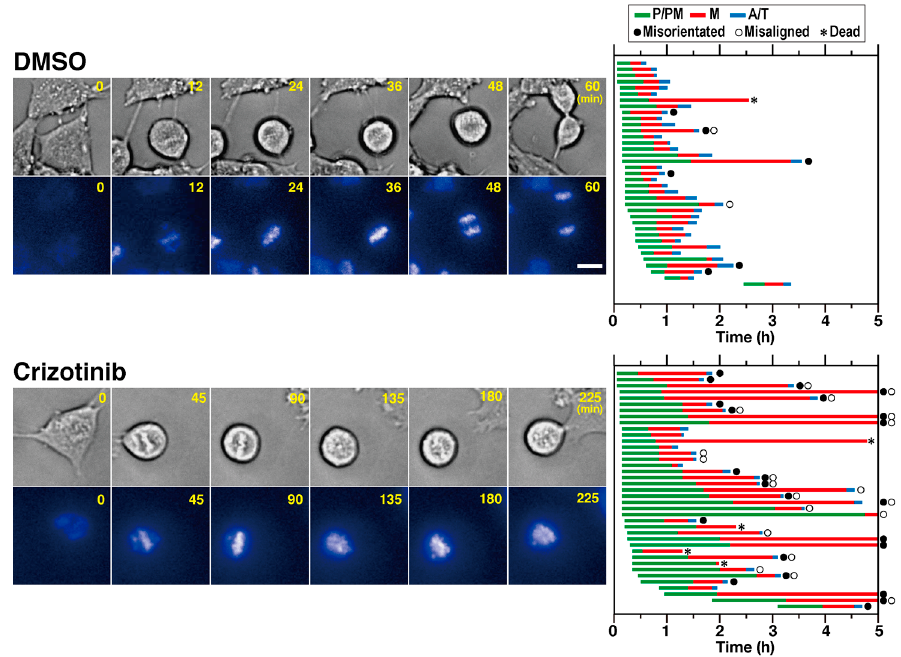
Figure 2. Crizotinib delays both prophase / prometaphase and metaphase. The SH-SY5Y cells were synchronized with 4 µ M RO-3306 and their M-phase progression in presence and absence of 1 µ M crizotinib were observed every 3 min for 5 h using time-lapse imaging. Representative images of solvent control (DMSO) and crizotinib-treated cells are shown. Scale bar = 10 µ m. Durations of prophase and prometaphase (P / PM, green), metaphase (M, red), and anaphase and telophase (A / T, blue) for 37 control and 39 crizotinib-treated cells are shown in the graph. Cells showing misoriented spindle, misaligned chromosomes, and cell death are indicated by closed circle, open circle, and asterisk,